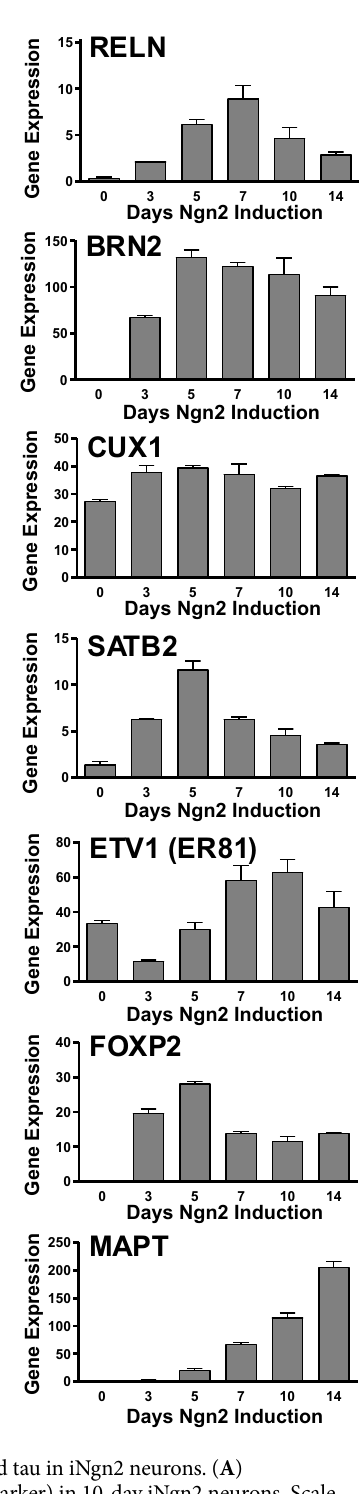
Figure 2. Expression of cortical glutamatergic excitatory markers and tau in iNgn2 neurons. ( A ) Immunostaining of SMI312 (axonal marker) and MAP2 (dendritic marker) in 10-day iNgn2 neurons. Scale bar represents 50 μm. ( B ) As assessed by western blots, there is robust expression of synaptic proteins Synapsin 1 and PSD-95, and the glutamatergic marker GluR1 in 14-day iNgn2 neurons from acutely transduced iPSC and NPC, and the iNgn2-NPC stable cell line. For comparison, human brain tissue from the anterior cingulate cortex (ACC) was also probed. Full-length blots are presented in Supplementary Fig. S11. ( C ) By 18 days of iNgn2, the neurons exhibit numerous synaptic punctae consisting of colocalized presynaptic marker VGLUT1 and postsynaptic marker HOMER1 along neuronal processes immunostained with the p-Tau marker PHF-1. Scale bar represents 20 μm. ( D ) These neurons also express cortical layer marker and tau mRNA (as transcripts per million, TPM) as determined by